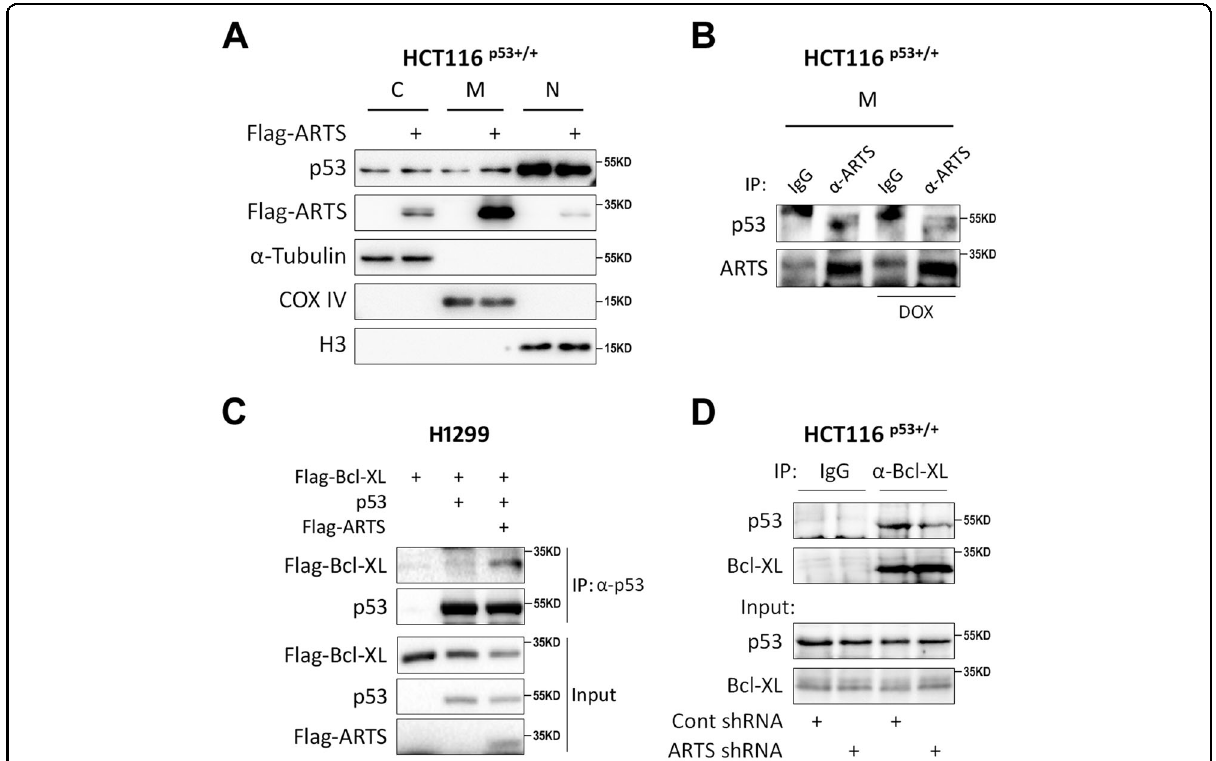
Fig. 5 ARTS enhances p53 – Bcl-XL interaction. A Overexpression of ARTS promotes mitochondrial accumulation of p53. HCT116 p53 + / + cells were transfected with Flag-ARTS or the vector plasmid and subjected to cellular component fractionation. IB assays were performed to assess the expression of p53 and ARTS in the nucleus, cytoplasm, and mitochondria, respectively. The expression of COX IV indicates the mitochondrial fraction. B ARTS interacts with p53 in the mitochondria. The mitochondrial fraction of HCT116 p53 + / + cells was prepared for the co-IP assay using antibodies as indicated. C Overexpression of ARTS enhances the interaction of p53 with Bcl-XL. H1299 cells were transfected with plasmids as indicated followed by the co-IP-IB analyses. D Knockdown of ARTS reduces the interaction of p53 with Bcl-XL. HCT116 p53 + / + cells expressing control or ARTS shRNA were subjected to co-IP-IB analyses using antibodies as